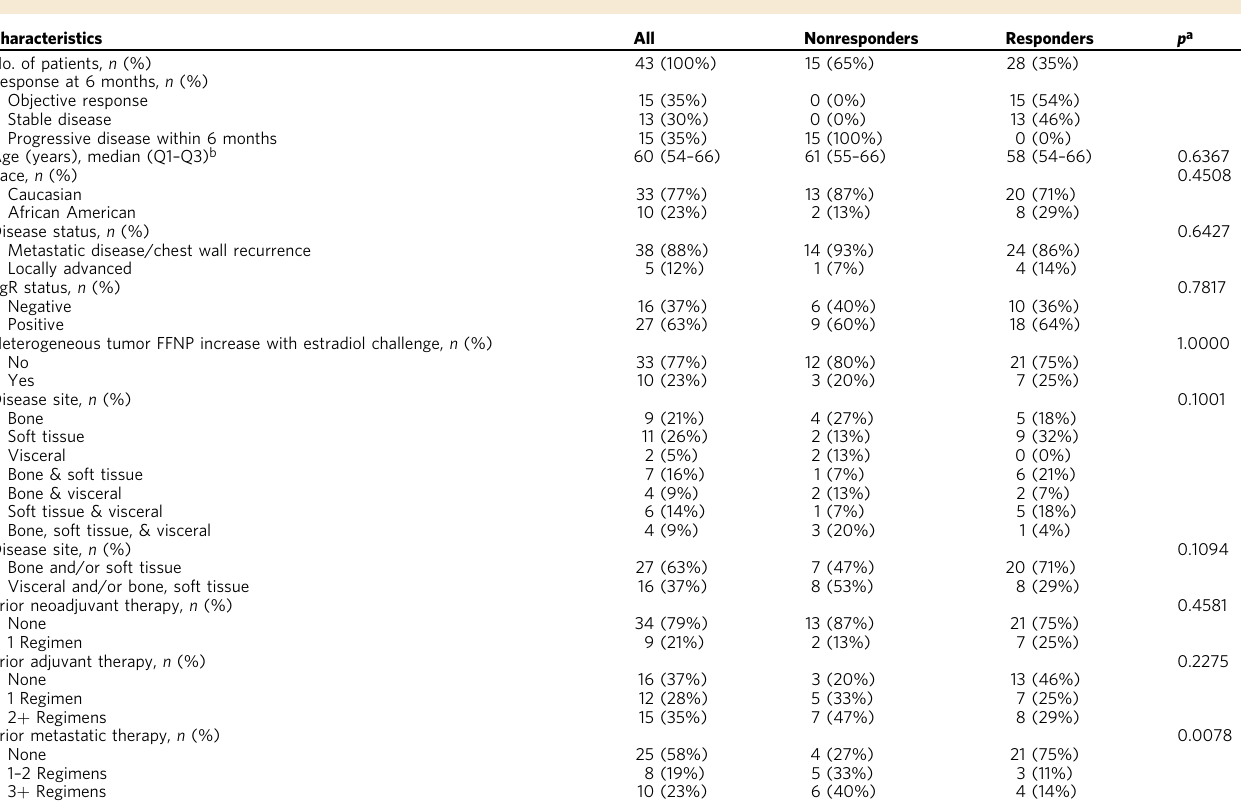
Table 1 Patient characteristics by clinical bene fi